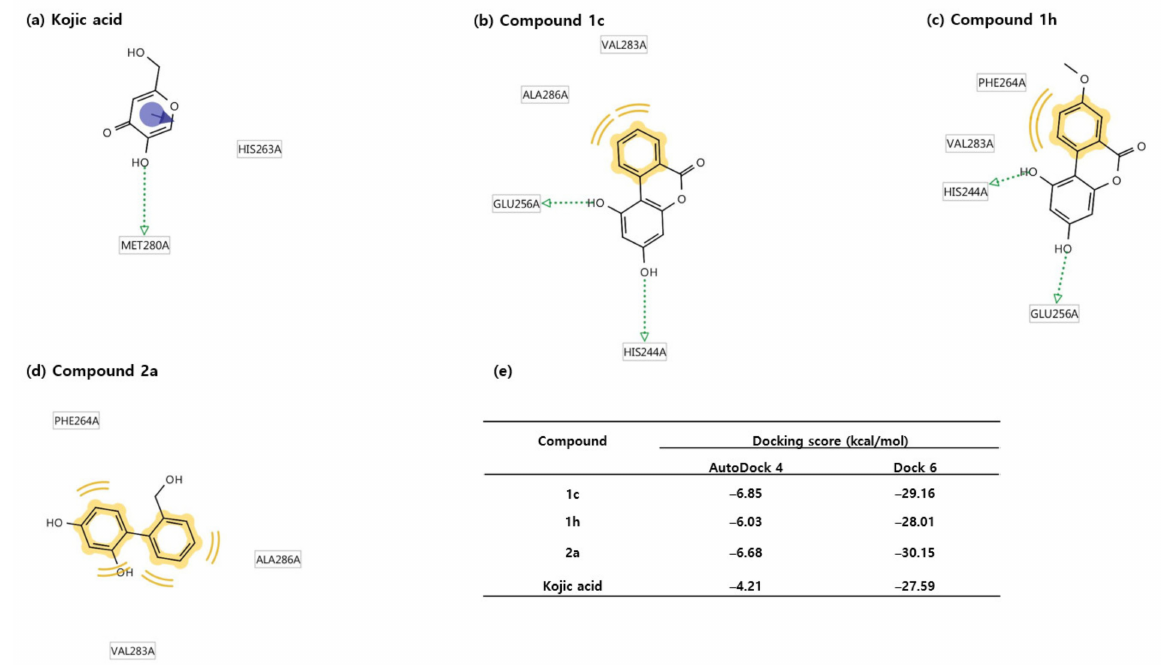
Figure 5. Docking simulation of urolithin derivatives 1c and 1h, o -phenylbenzyl alcohol derivative 2a, and kojic acid with Agaricus bisporus tyrosinase using AutoDock 4 and Dock 6 and pharmacophore analysis. ( a – d ) Pharmacophore results for 1c, 1h, 2a, and kojic acid obtained from LigandScout 4.2.1 based on AutoDock 4 indicated possible hydrogen bonding (green arrows), π - π stacking (violet arrow) and hydrophobic (yellow double arcs) interactions between tyrosinase amino acid residues and the ligands. ( e ) Docking scores between tyrosinase and the ligands 1c, 1h, and 2a, and kojic acid are tabulated (PDB code: